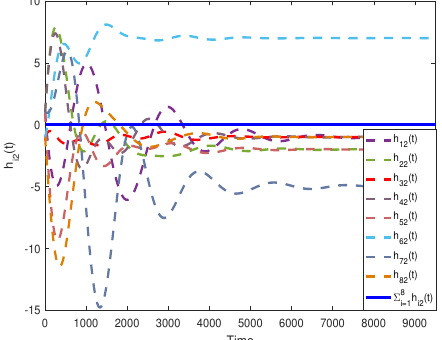
Figure 7. The trajectories of h i 2 ( t ) .